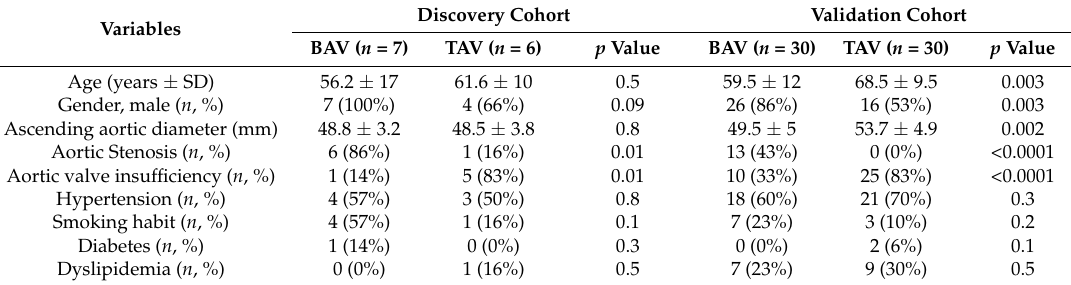
Table 3. Clinical and demographic characteristics of study